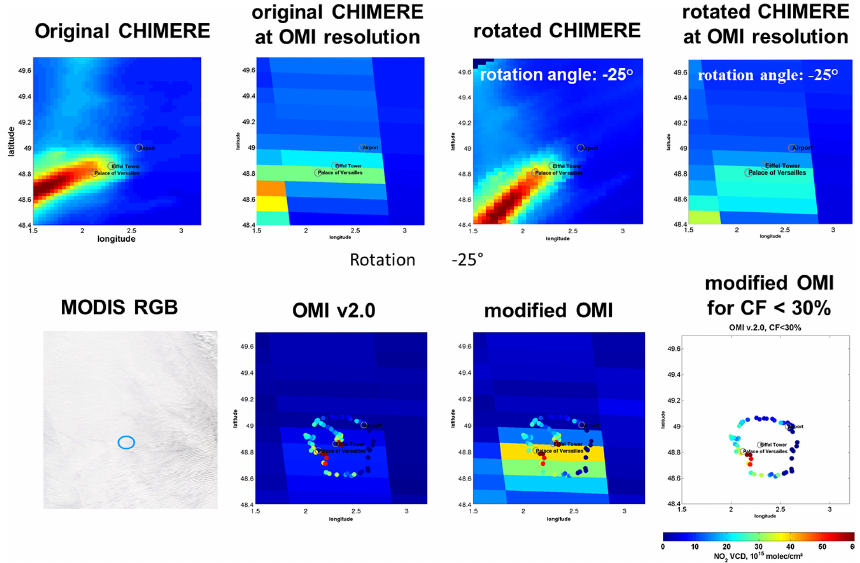
Figure 16. Comparison of different versions of OMI and CHIMERE data for 8 February 2010. Also shown are a MODIS RGB image and the car-MAX-DOAS results of that